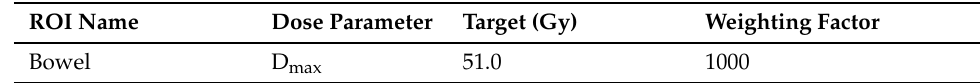
Table 1. Priority 1—Primary OAR Goals.